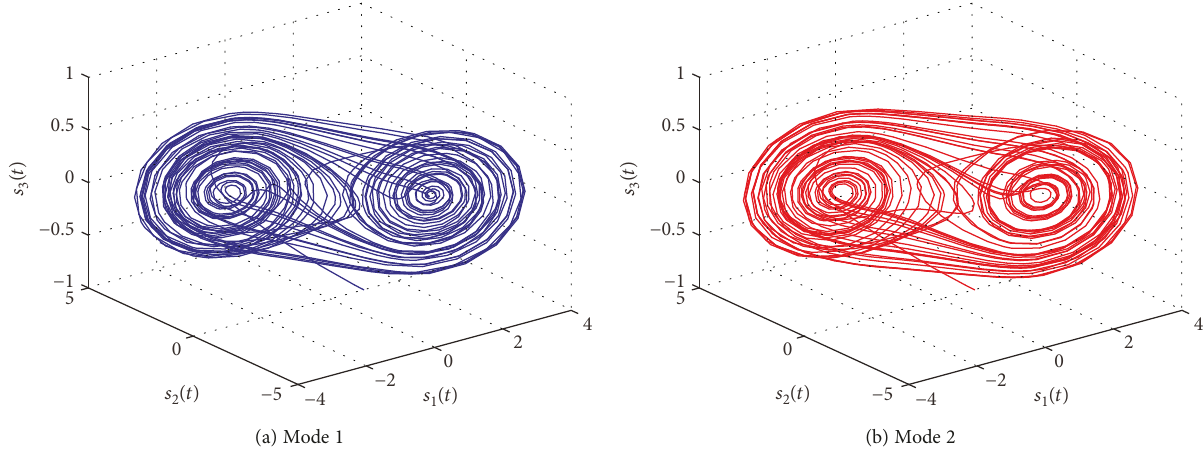
Figure 4: The state responses of the unforced isolated node.